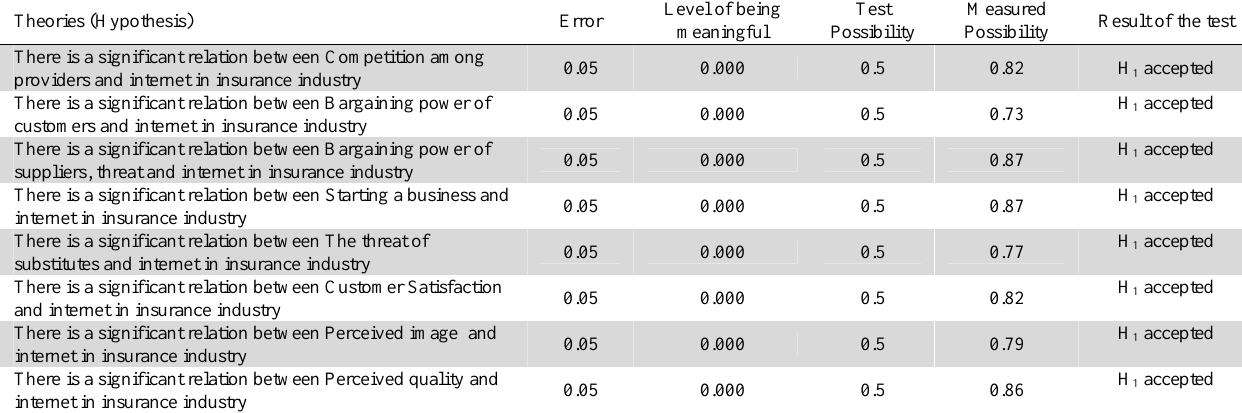
Statistical measures to test the hypotheses binomial